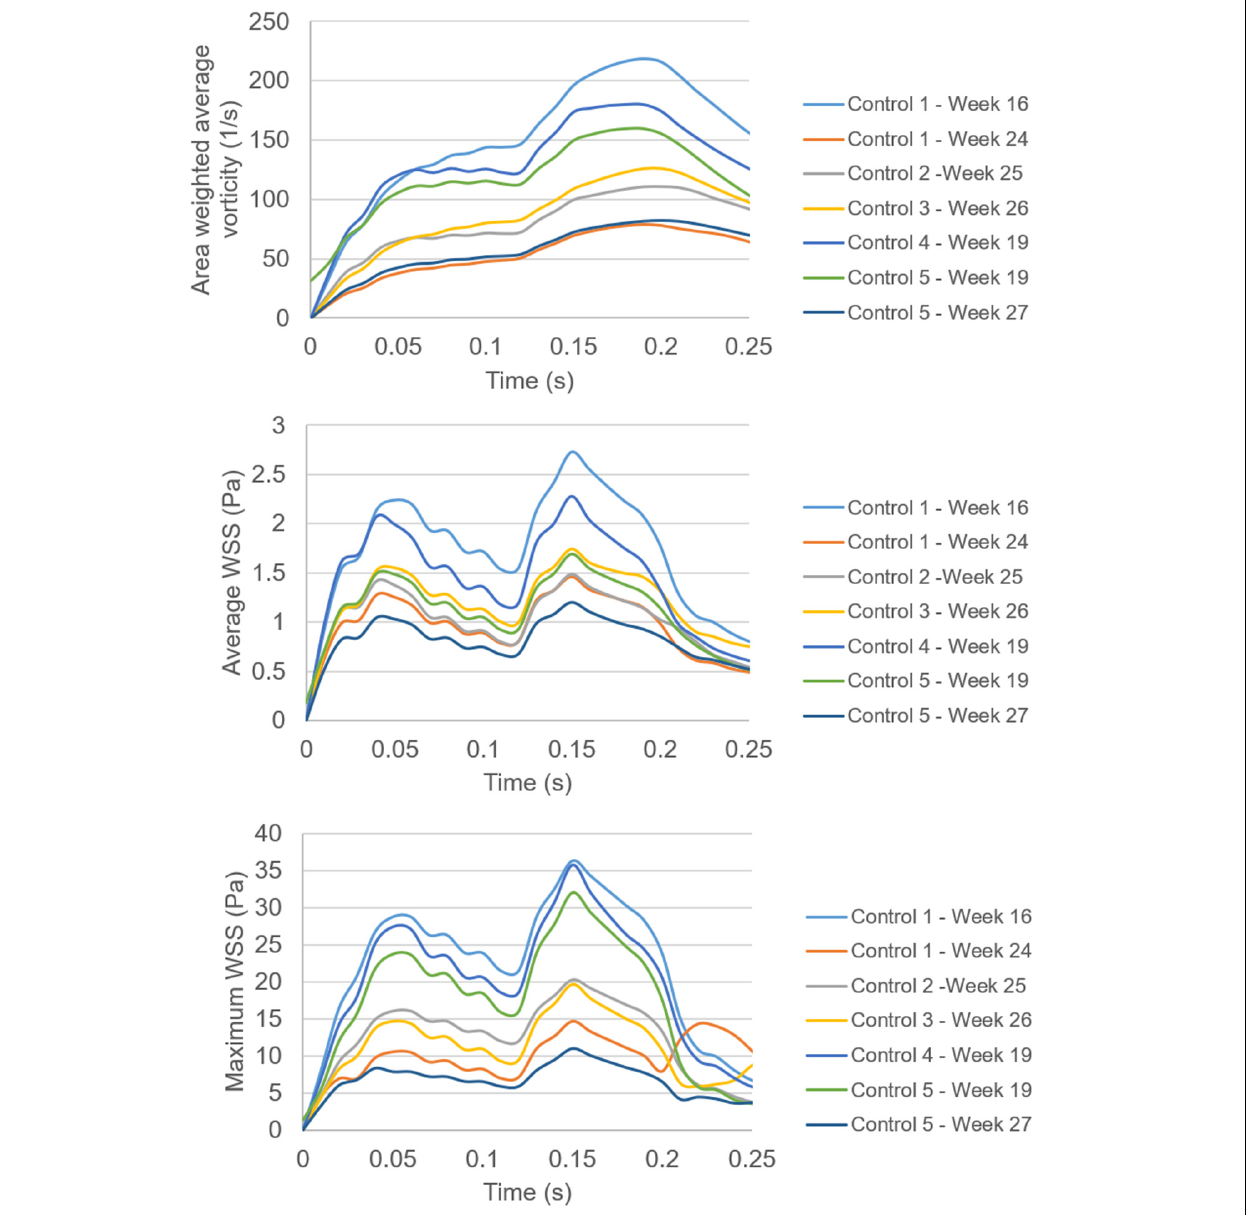
FIGURE 14 | Comparison of the area weighted average vorticity in the flow domain, the average WSS around the mitral valve, and the maximum WSS around the mitral valve. Spatially averaged values of WSS are determined by averaging the WSS levels across the entire wall of the models. Spatially averaged vorticity levels are determined by averaging the values over the entire flow area in the